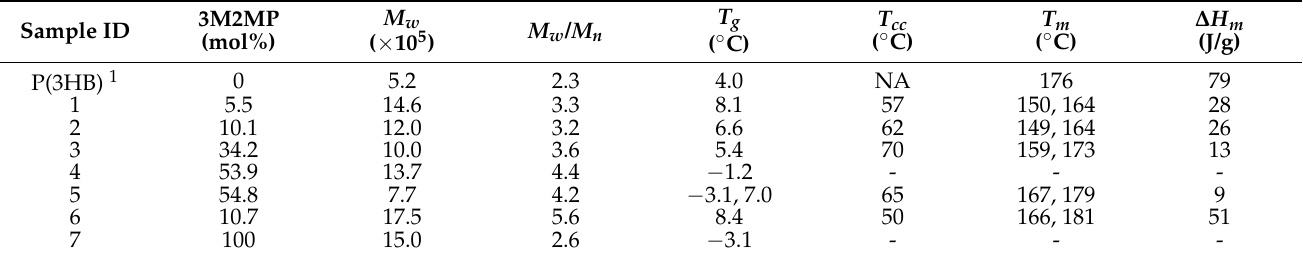
Table 3. Molecular weight and thermal properties of the